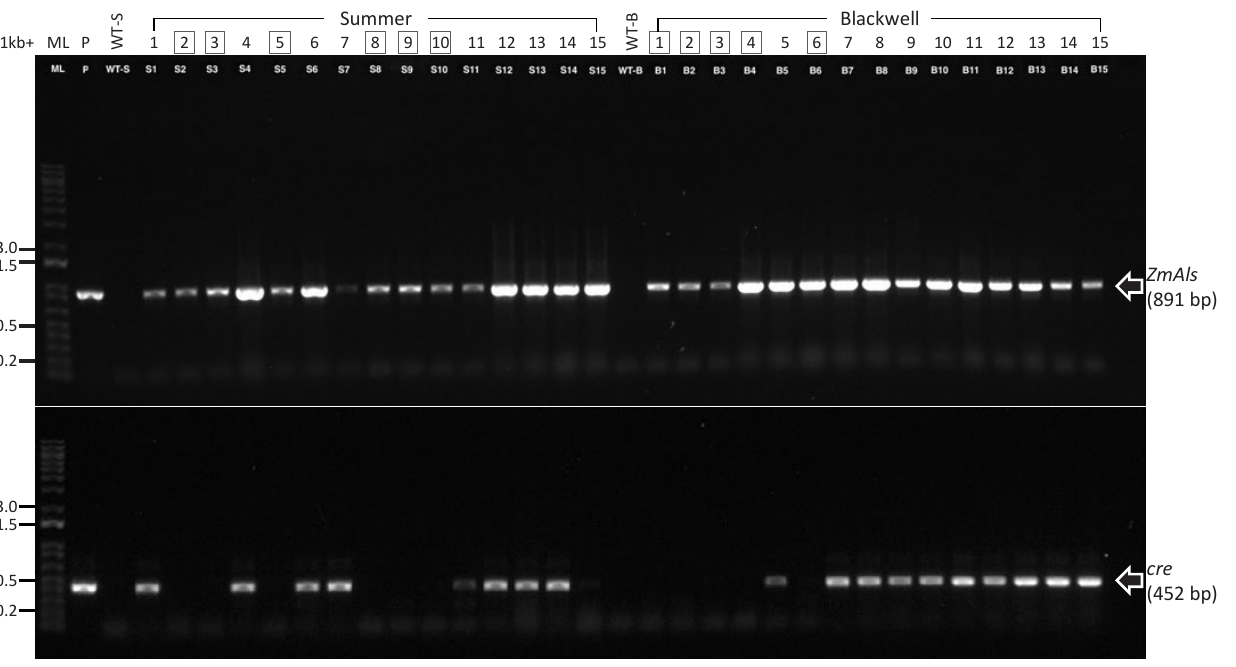
FIGURE 3 | Characterization of putative transgenic plants. PCR reactions were performed for 15 putative transgenic plants of Summer (S1–S15) and Blackwell (B1–B15), respectively, for the presence of the herbicide resistance gene ZmAls (891 bp, top panel) and cre gene (452 bp, lower panel). ML, 1-kb molecular ladder; P, plasmid DNA as positive control; WT-S, Summer wild type; WT-B, Blackwell wild type. Boxed numbers denote desired transgenic plants with the cre gene